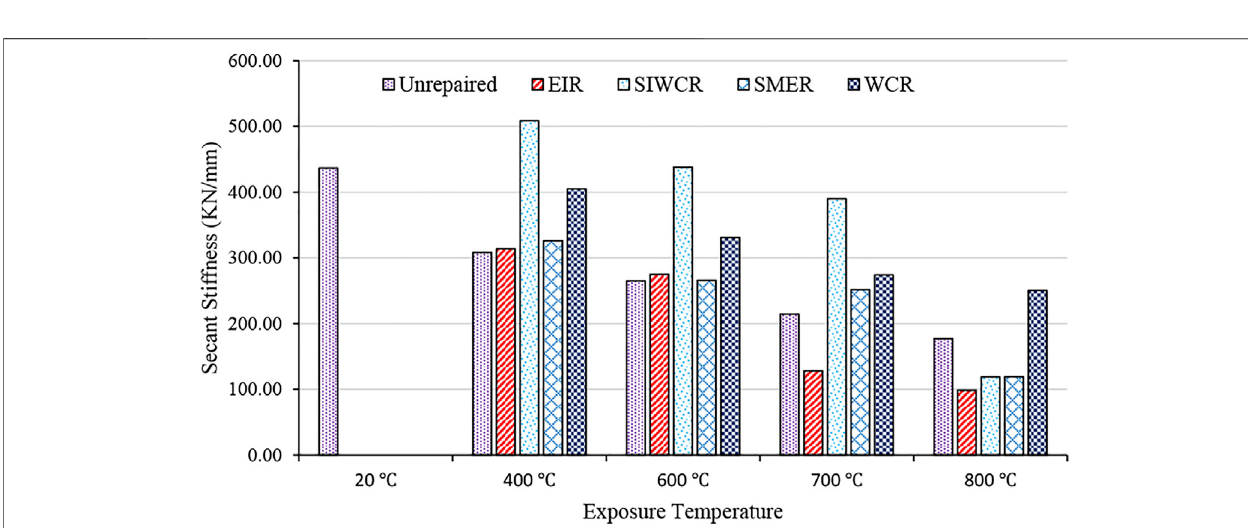
FIGURE 11 | Comparison of ultimate compressive strengths for various repair techniques and temperature exposures.